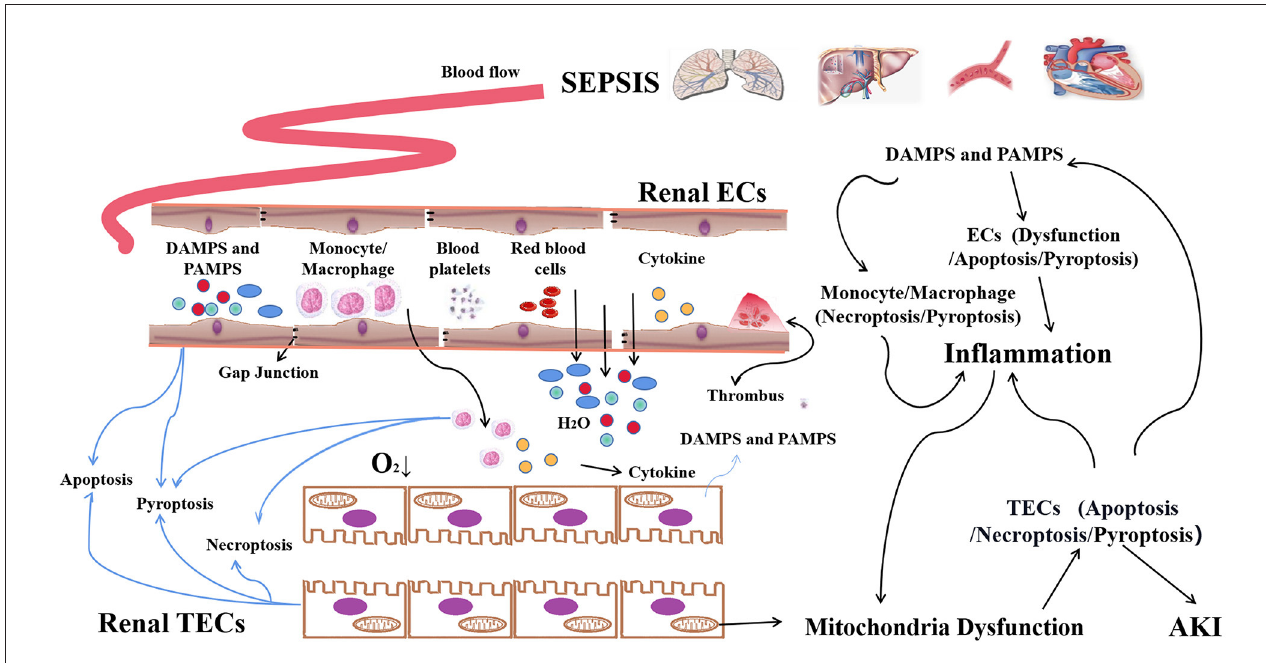
FIGURE 1 | The programmed death of macrophages, ECs, and TECs in sepsis-AKI. In sepsis, PAMPs and/or DAMPs that are released from damaged tissues activate and increase the pro-inflammatory phenotype (M1) forms of macrophages, leading to the release of pro-inflammatory cytokines which can cause damage to the kidney tissue of bystanders. PAMPs/DAMPs and etc present in the plasma can induce the dysfunction and cell death of vascular ECs. Abnormalities in the contraction and relaxation of local blood vessels, as well as the formation of microthrombus, result in the restriction of local blood supply and microcirculation disorders. Apoptosis and pyroptosis of ECs result in the increasing of vascular permeability. Thereafter, a large amount of fluid, endotoxin and inflammatory factors and cells permeated into the renal interstitium, further exacerbating local hypoxia. The infiltrating inflammatory cells and inflammatory factors, as well as the ROS, attacked TECs. Finally, TECs undergo apoptosis, pyroptosis and necroptosis, leading to